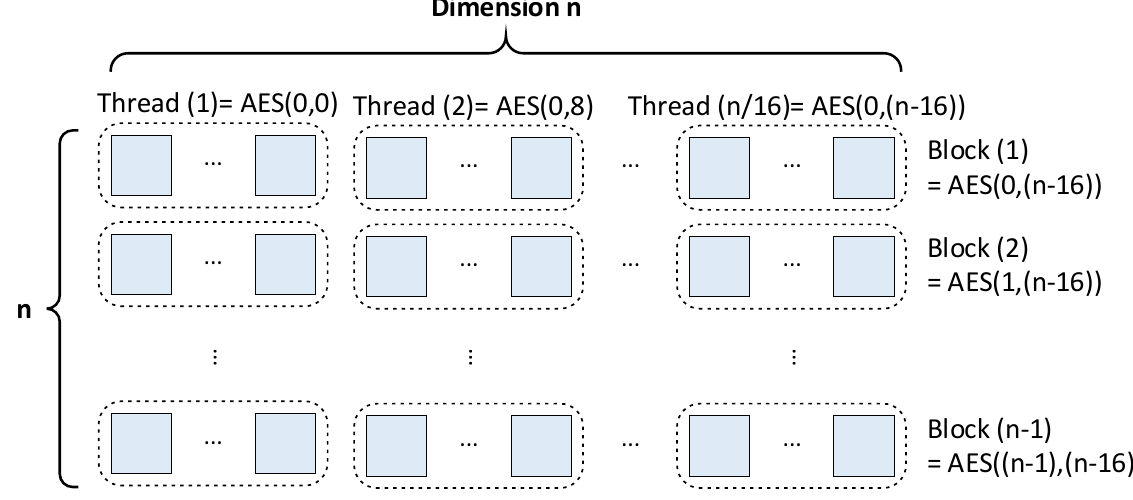
Figure 4. Matrix A parallel generation